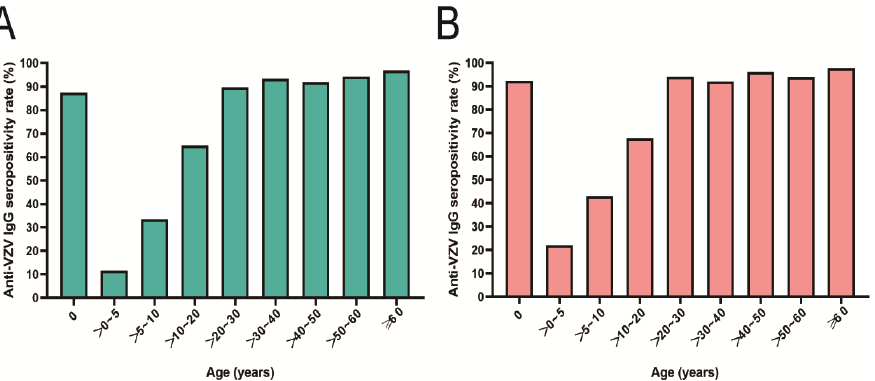
Figure 1. ( A ) Seroprevalence of anti-VZV IgG in non-VarV-vaccinated participants in Zhanjiang; ( B ) seroprevalence of anti-VZV IgG in non-VarV-vaccinated participants in Heyuan. Table 1. Seroprevalence of anti-VZV IgG in non-VarV-vaccinated participants. Age (Years), No. (%)